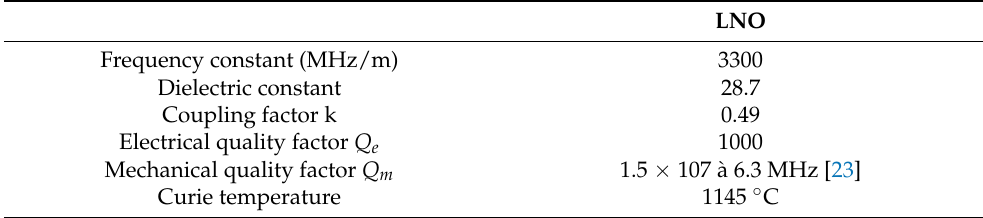
Table 1. Characteristics of Y − 36 ◦ cut LNO resonant in thickness